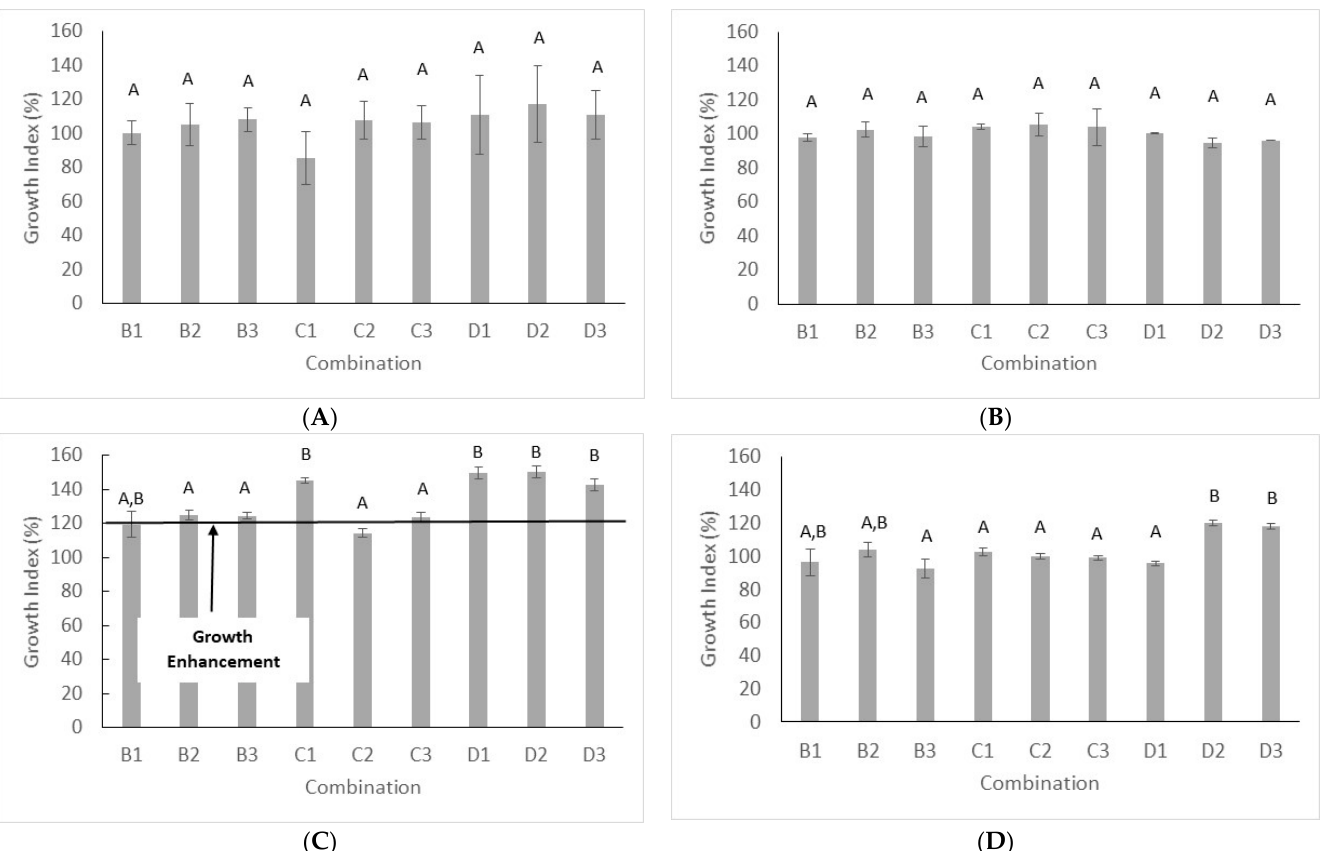
Figure 1. Growth Index (%) of US-treated S. cerevisiae 17 ( A ) and S. cerevisiae 41 ( B ) after 24 h in YPG incubated at 37 °C and S. cerevisiae 4y ( C ) and S. cerevisiae WB ( D ) after 48 h in YPG with 5% NaCl added incubated at 25 °C. The growth index was evaluated as the ratio absorbance of treated yeasts vs. absorbance of untreated yeasts (combination A1). Mean values ± standard deviation. Letters indicate significant differences (one-way ANOVA and Tukey’s test, p < 0.05).